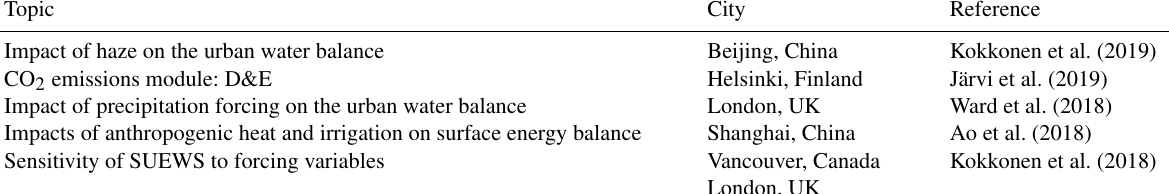
Table 1. Recent studies using SUEWS. D&E – development and evaluation. n/a – not applicable